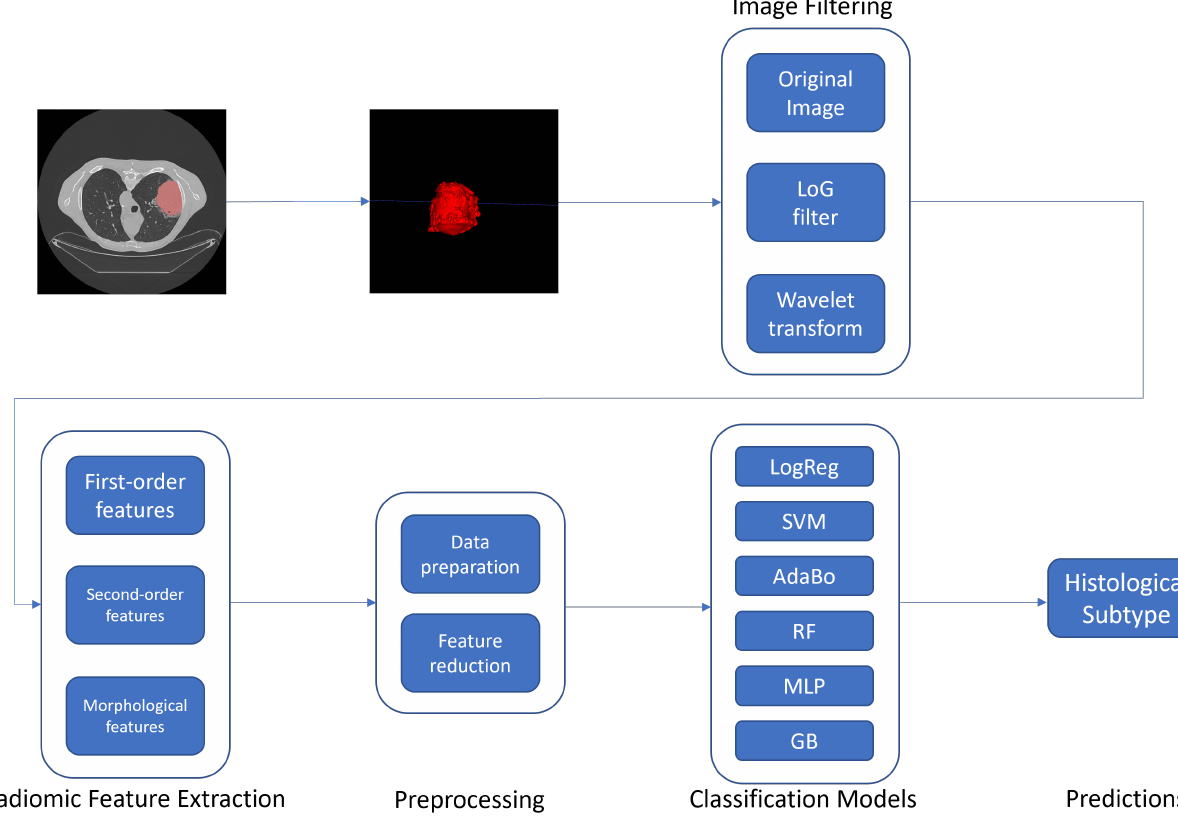
Figure 1. Radiomics workflow. The complete workflow includes the segmentation of the lung region, filtering to enhance the image, extraction of radiomics features, classification models and statistical